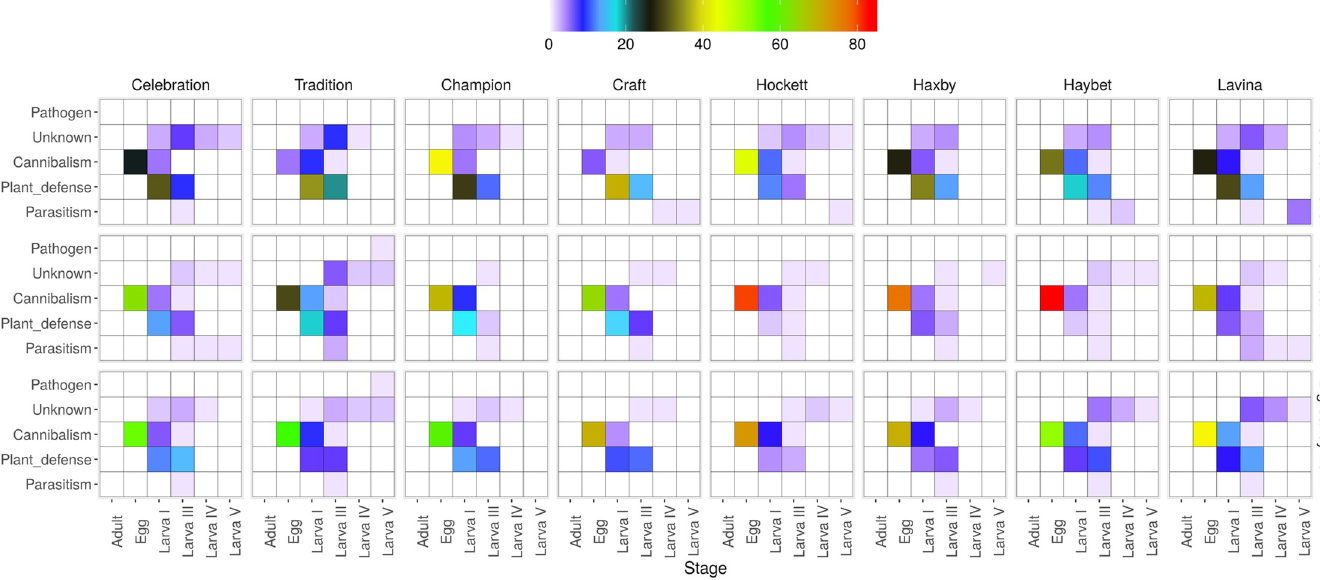
Fig 1. Heat map displaying the percentage of mortality by each cause of mortality at each developmental stage for Cephus cinctus in barley cultivars that were grown in Montana. Larva I: Pre-parasitism period; Larva III: Parasitism period; Larva IV: Overwintered larva (pre-flight period; post-parasitism); Larva V: Overwintered larva (post-flight period;